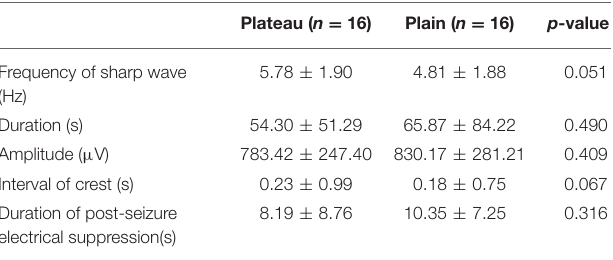
TABLE 1 | Electroencephalogram parameters in the plateau and plain groups. Values are the mean ±